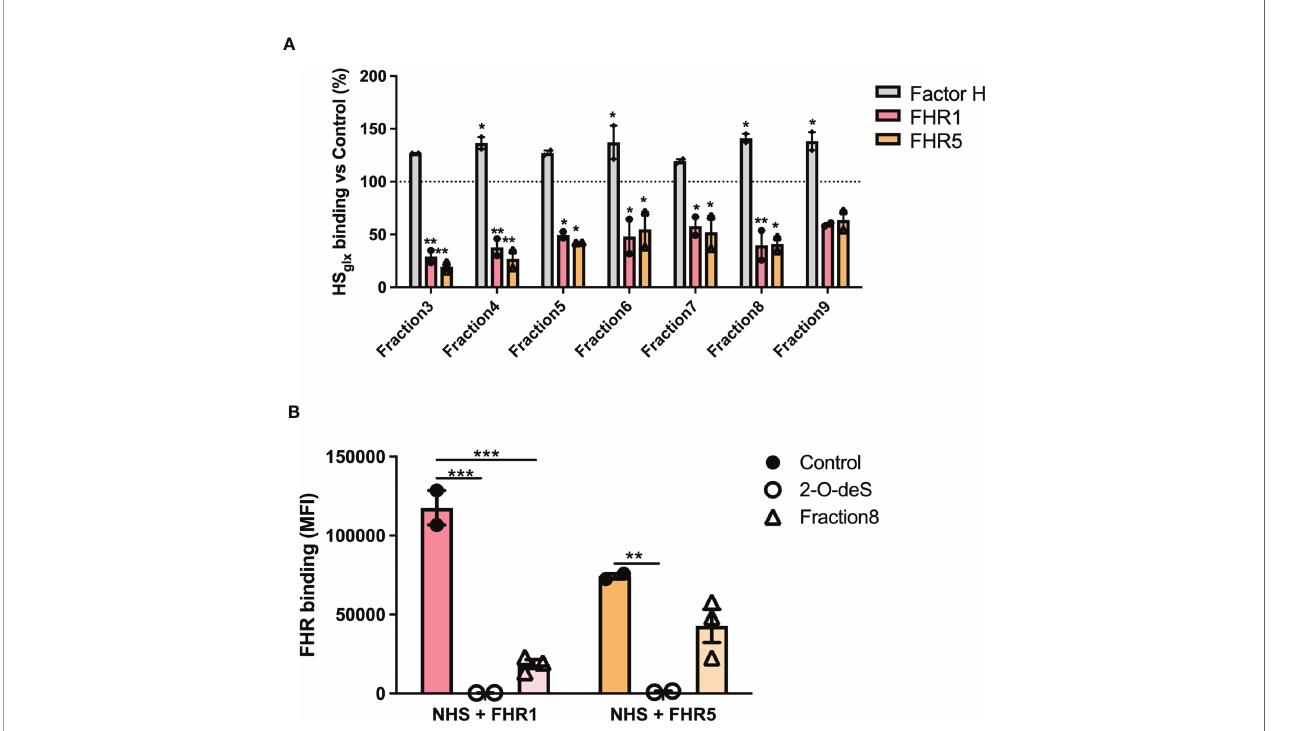
FIGURE 4 | 2-O-desulfated heparin fragments with a size equal to or larger than tetrasaccharides reduce FHR1 and 5 binding to puri fi ed glomerular endothelial HS Glx and ciGEnCs, without affecting FH binding to HS Glx . To determine the minimal oligosaccharide size required for FHR1 and FHR5 competition, proteins were preincubated with equimolar amounts of 2-O-desulfated heparin digest size exclusion chromatography fractions (n=2) (A) . Addition of 2-O-deS heparin or short 2-O- deS oligosaccharides (Fraction8) to FHR-supplemented serum signi fi cantly reduced FHR binding to ciGEnCs (n ≥ 2) (B) . (*p < 0.05, **p < 0.01, ***p < 0.001 vs